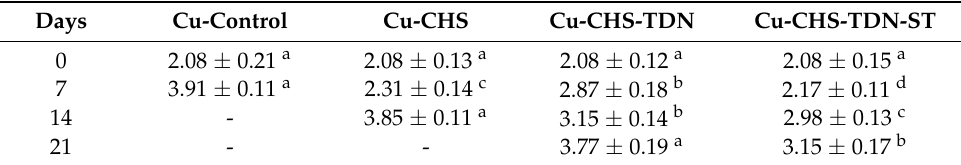
Table 2. Effect of coating treatments on fungal populations (log